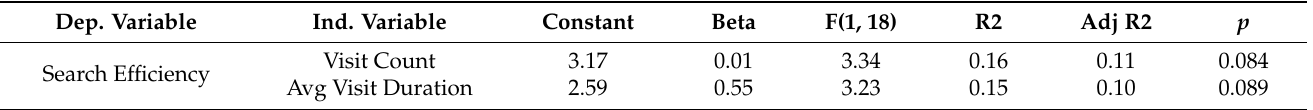
Table 10. Regression—search efficiency (average convex hull coverage) by pipefitter interaction (visit count, average visit